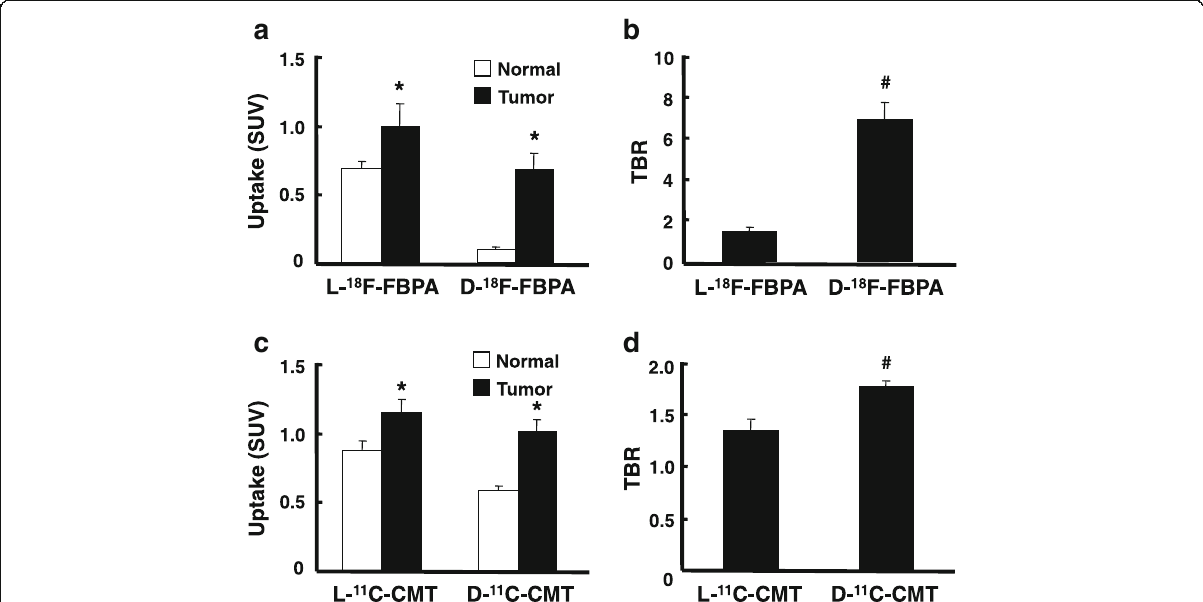
Fig. 4 Uptakes ( a , c ) and TBRs ( b , d ) of L- and D- 18 F-FBPA ( a , b ) and L- and D- 11 C-CMT ( c , d ) into C6 glioma-bearing rat brains. PET scans were performed as shown in the legend of Fig. 2, and the VOIs of glioma and contralateral normal regions were set on the summation SUV images from 60 to 90 min for 18 F-FBPA ( a ) and from 30 to 60 min for 11 C-CMT ( c ). The target tumor (glioma) to non-target (normal) ratios of L- and